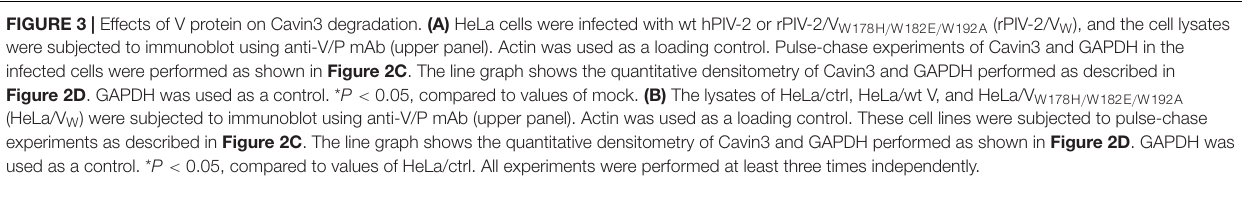
stained with 0.05% neutral red at 5 days post-infection (dpi), and the number of plaques was